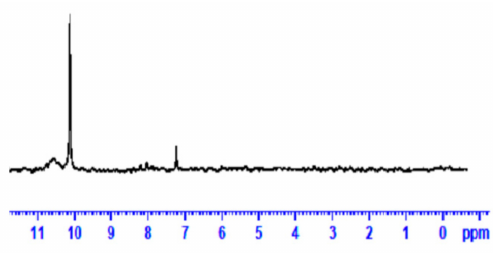
Figure 3. 13 C-NMR spectrum of MEP at 11–0 δ (ppm).